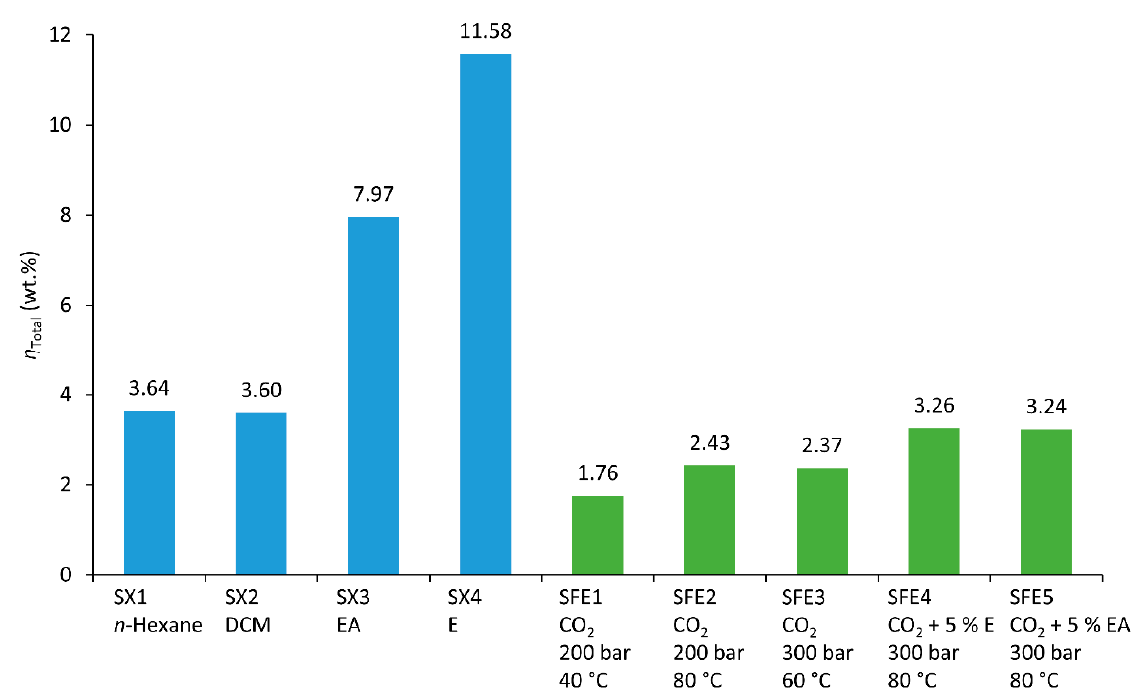
Figure 3. Total extraction yields ( η Total ) obtained by Soxhlet using n -hexane, dichloromethane (DCM), ethyl acetate (EA), ethanol (E) and SFE at different conditions.